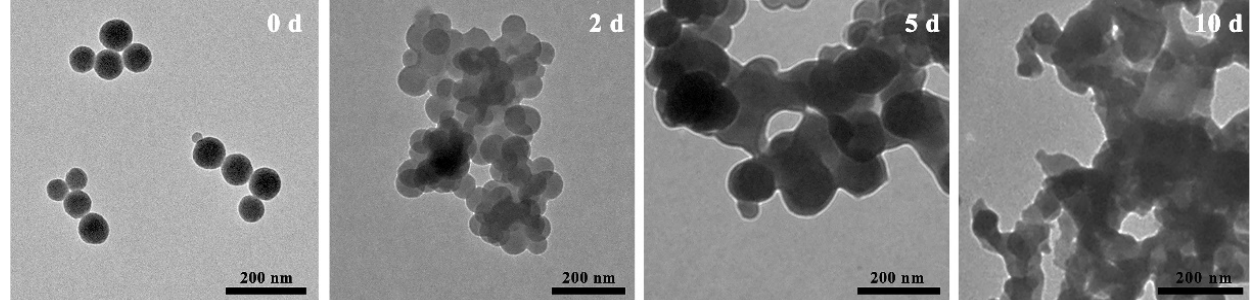
Figure 5. Degradation behaviors of DMON nanoparticles in 10 mM glutathione solution at 0, 2, 5, and 10